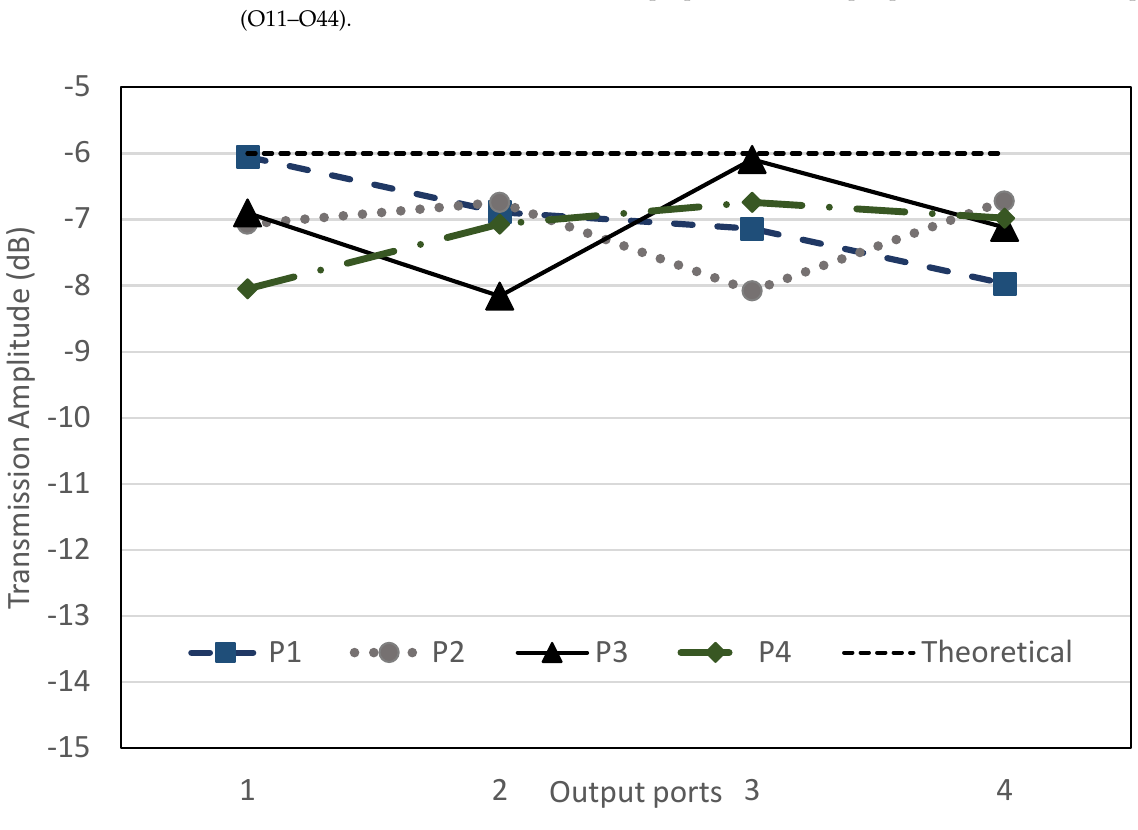
Figure 18. Transmission amplitude, S ij , of the proposed BM.